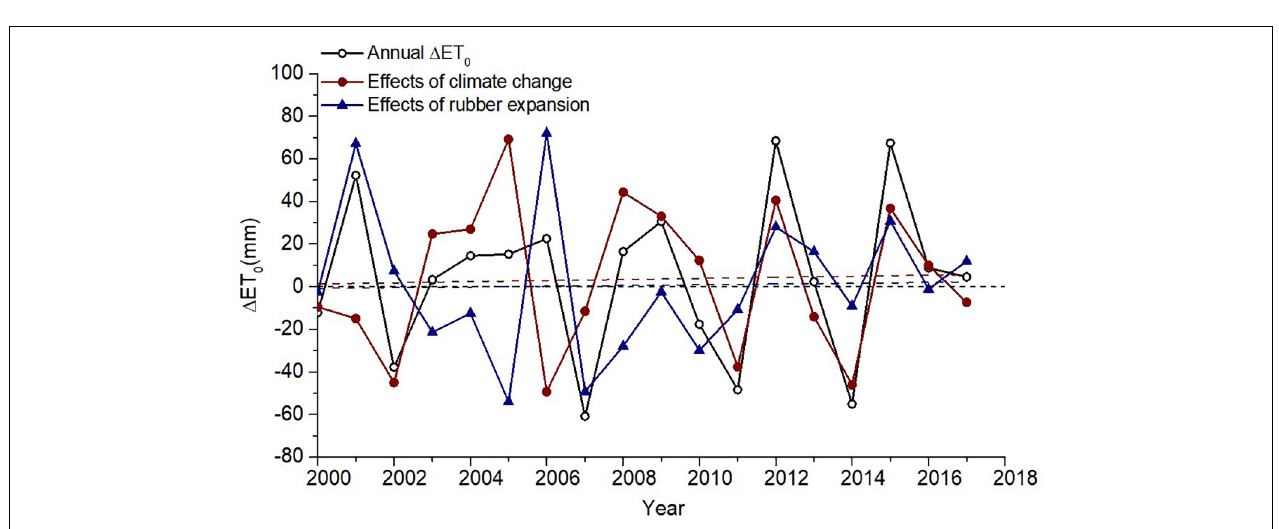
FIGURE 8 | Fluctuation of the impact of climate change and rubber plantation expansion on the annual mean ET0 change in